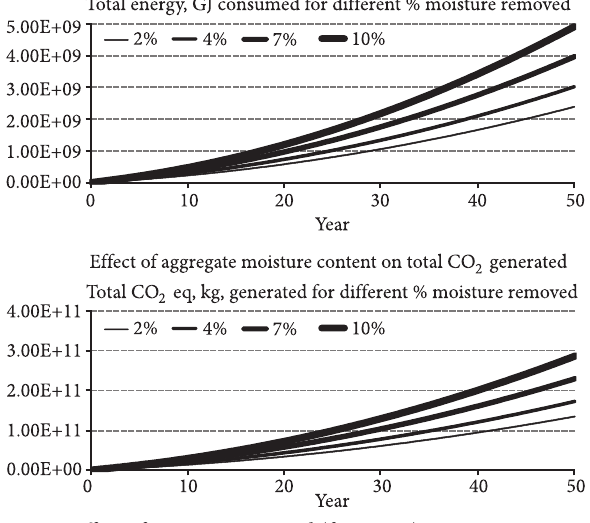
Fig. 6. Effect of moisture removed (from mix)